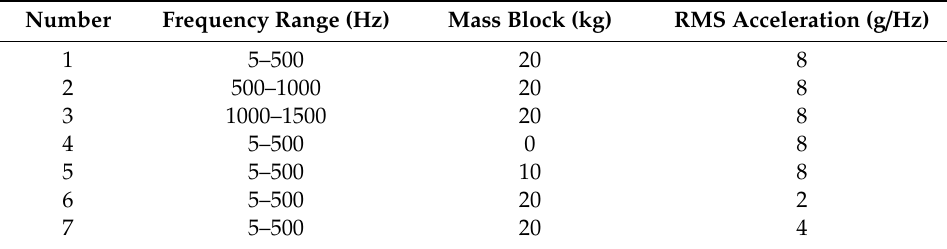
Table 1. Conditions for random vibration tests.